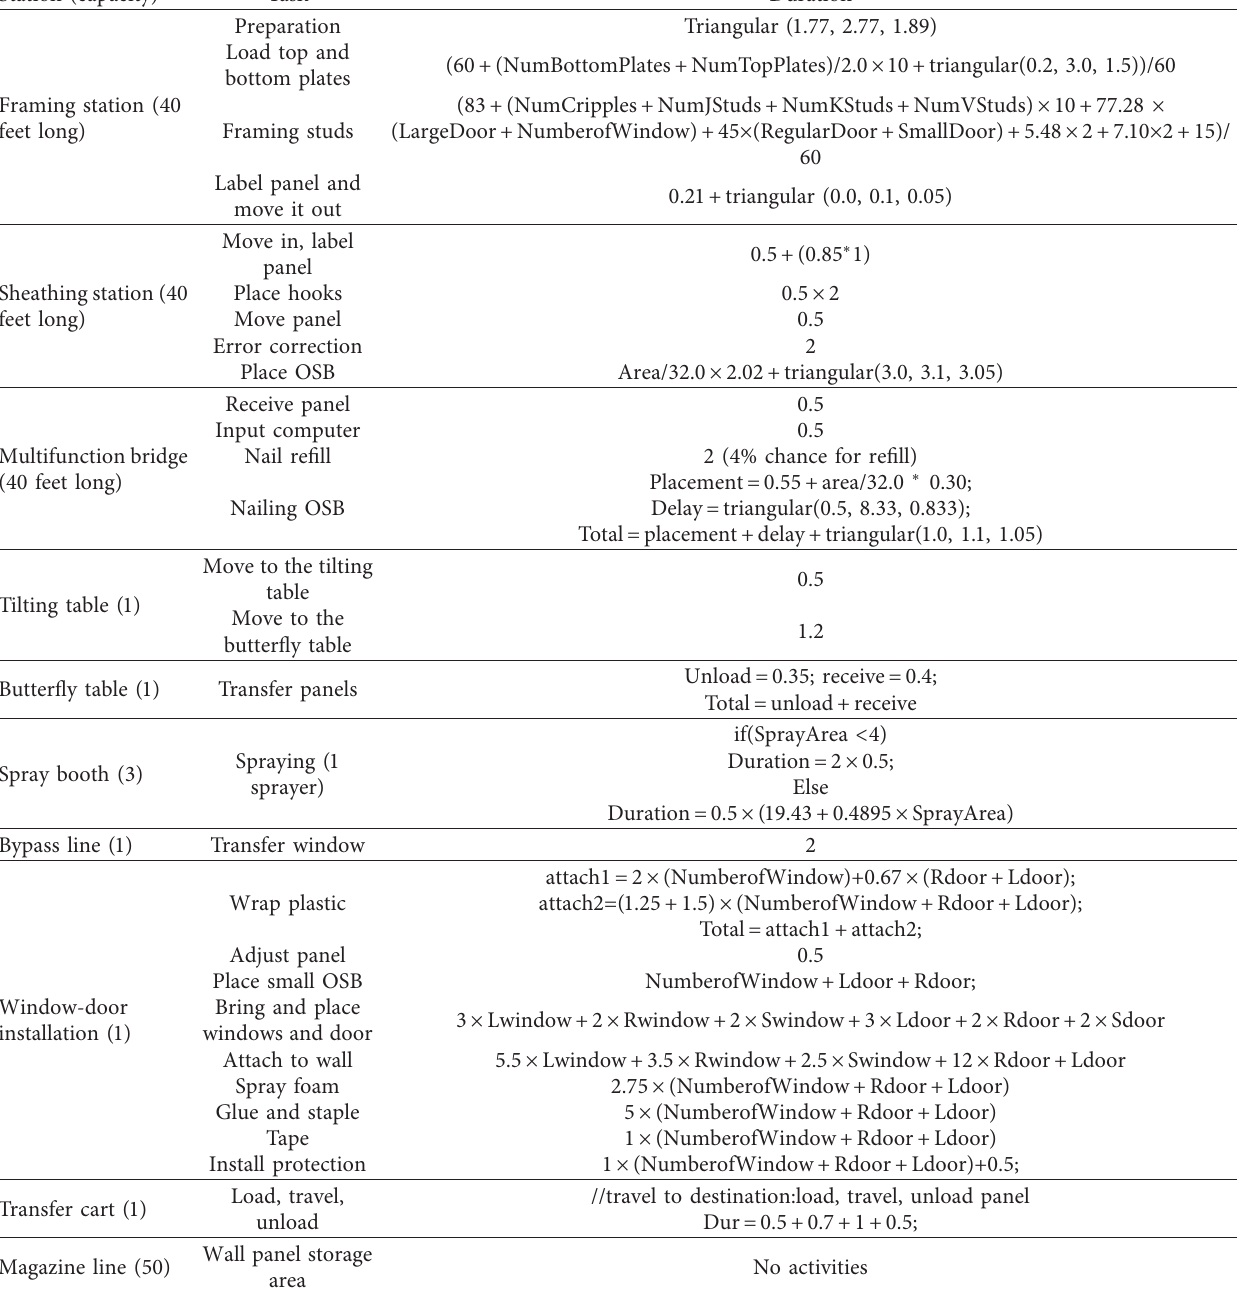
Table 1: Station, activities, and their duration for wall